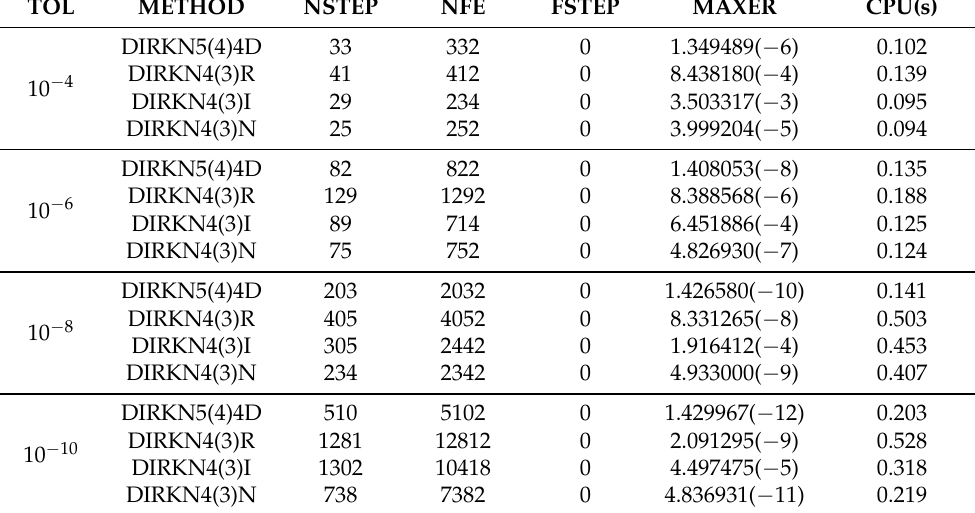
Table 5. Data for Example 4.